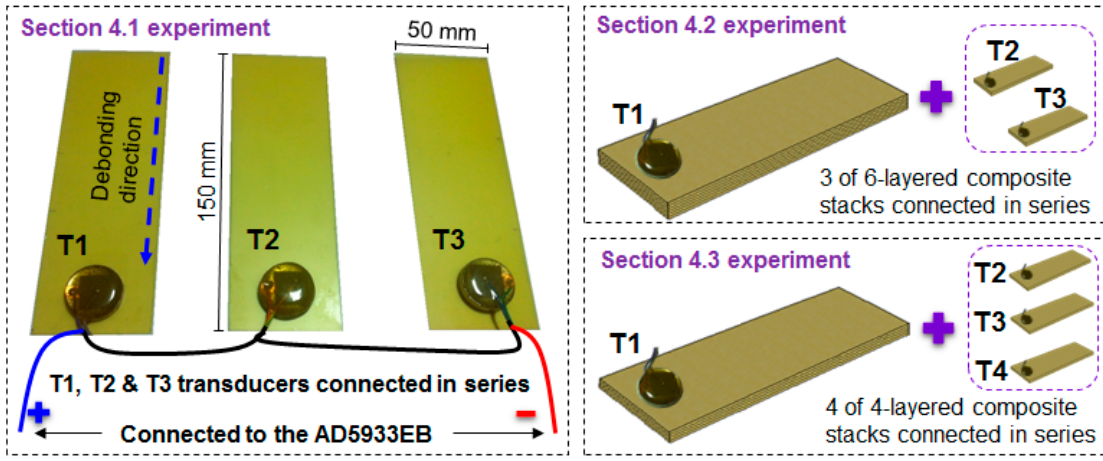
Figure 4. Test specimen setup for Sections 4.1–4.3.